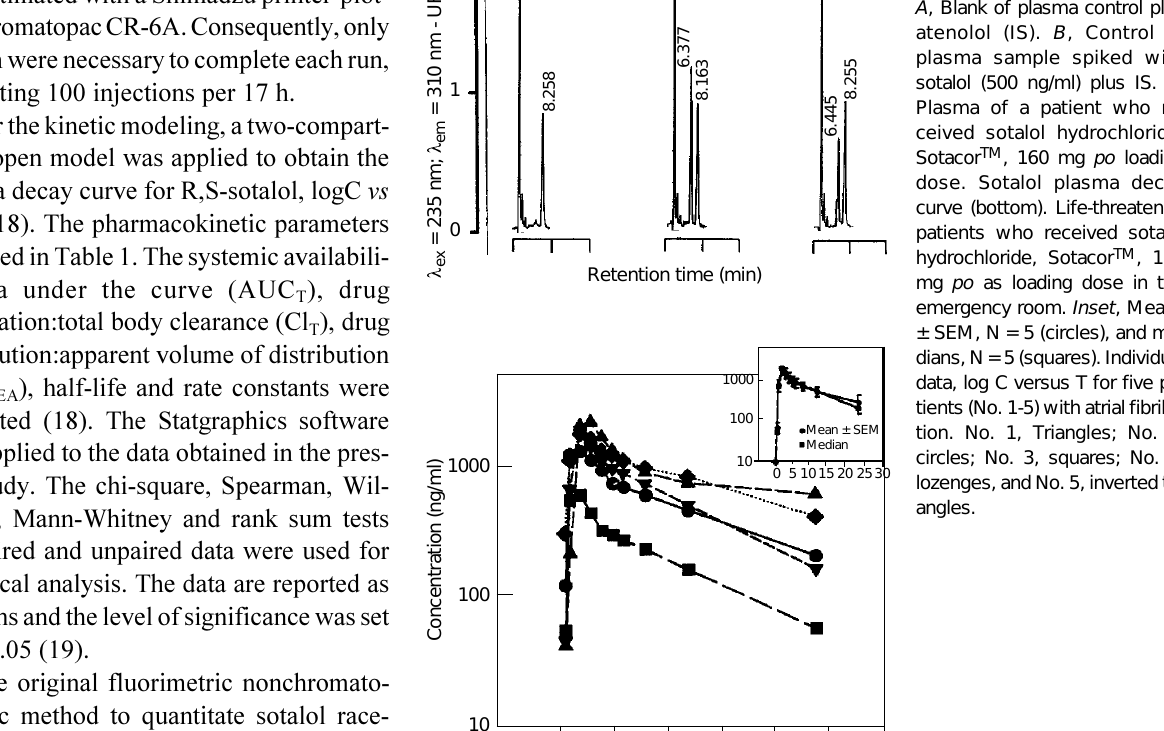
Figure 1 - Chromatographic pro- file of plasma sotalol and its in- ternal standard (atenolol) (top). A , Blank of plasma control plus atenolol (IS). B , Control of plasma sample spiked with sotalol (500 ng/ml) plus IS. C , Plasma of a patient who re- ceived sotalol hydrochloride, Sotacor TM , 160 mg po loading dose. Sotalol plasma decay curve (bottom). Life-threatened patients who received sotalol hydrochloride, Sotacor TM , 160 mg po as loading dose in the emergency room. Inset , Means ± SEM, N = 5 (circles), and me- dians, N = 5 (squares). Individual data, log C versus T for five pa- tients (No. 1-5) with atrial fibrilla- tion. No. 1, Triangles; No. 2, circles; No. 3, squares; No. 4, lozenges, and No. 5, inverted tri-